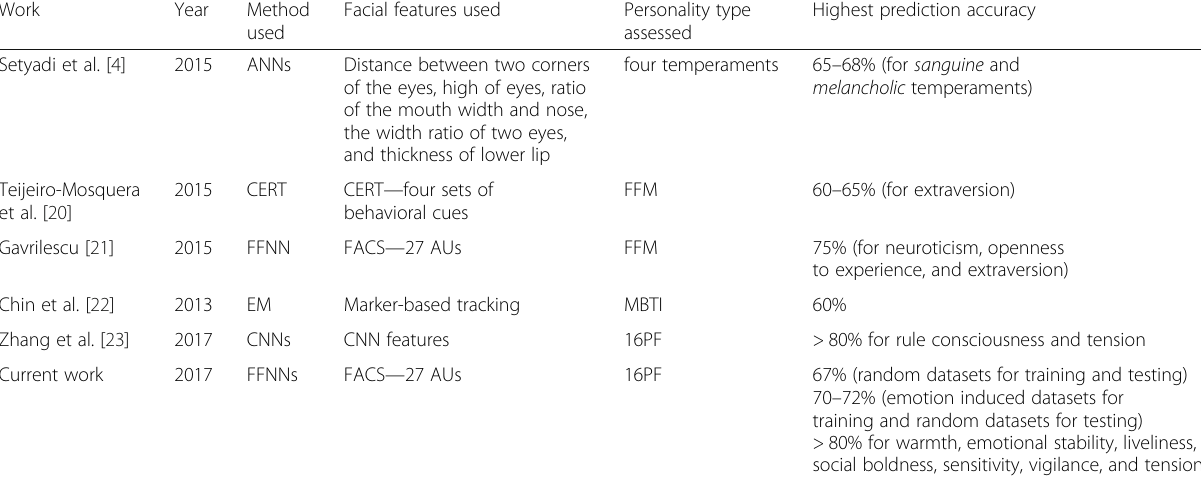
Table 7 Comparison with state-of-the-art